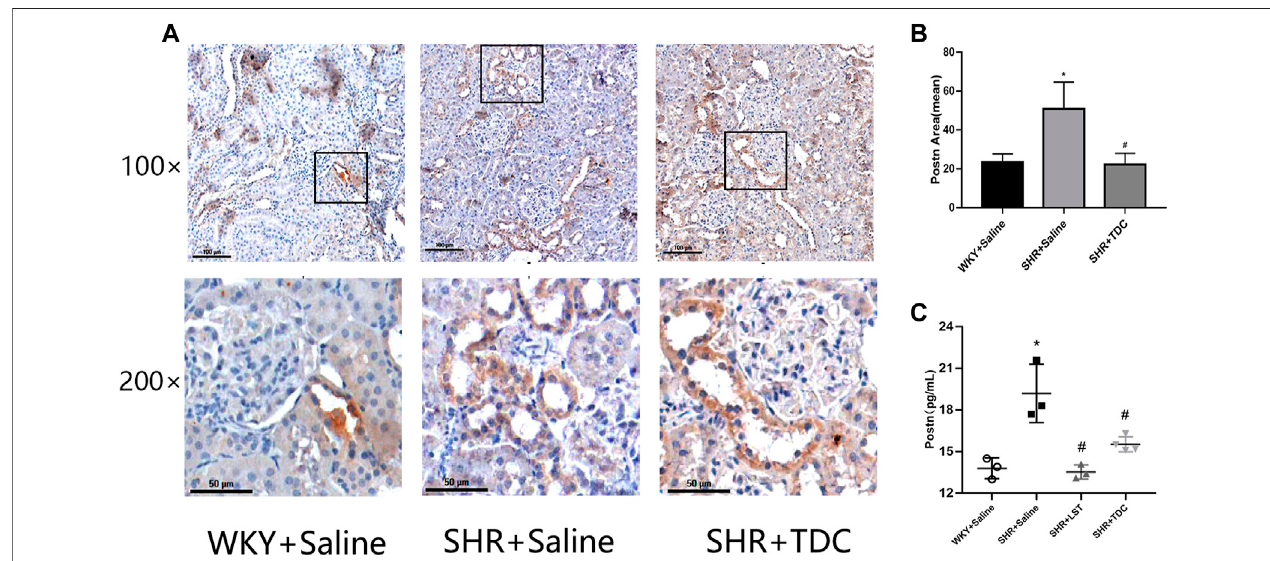
FIGURE 5 | Effects of TDC on periostin protein expression in SHR kidney in situ . After 4 weeks of treatment with TDC, periostin protein expression in renal tissues was detected by (A, B) immunohistochemistry and (C) ELISA (A) Representative immunohistochemical staining images for the kidney tissue section of SHR and WKY rats at × 100 (top) and × 200 (bottom) magni fi cations. Periostin protein was stained in brown (B) Bar graph quanti fi cation of periostin expression (C) Quanti fi cation of ELISA for periostin expression in renal tissue supernatants. Data are expressed as mean ± SD, n (cid:2) 3. * p < 0.05 vs. WKY rats; # p < 0.05 vs. SHR.